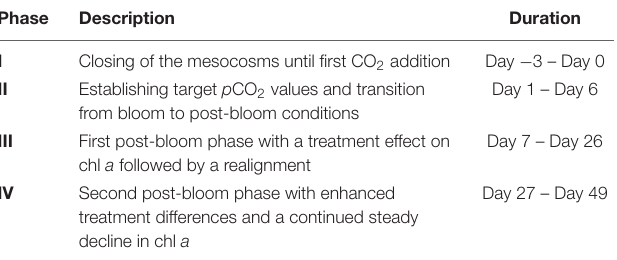
TABLE 2 | Overview, description and duration of the four different phases of the experiment based on p CO 2 additions/manipulations and chl a concentration